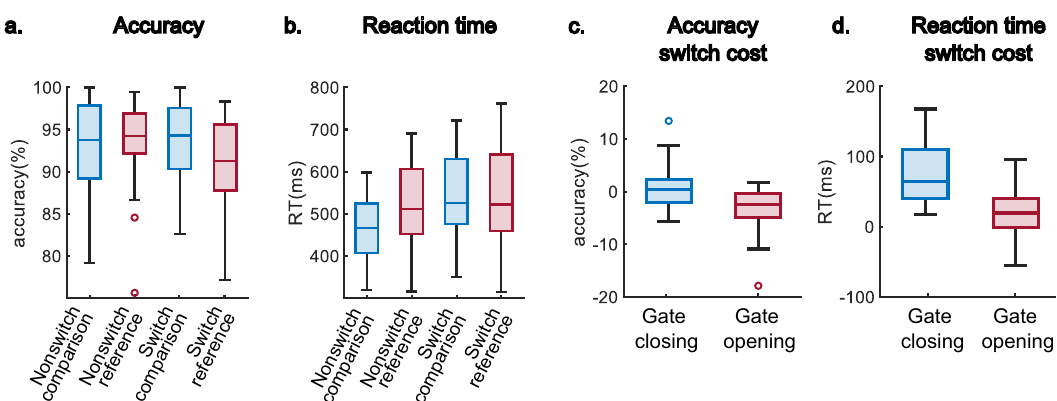
Fig. 1 Behavioral results for gate opening and gate closing. Behavioral results derive from N = 33 participants. Plots a and b reveal the accuracy and reaction time (RT) in each condition, respectively. Plots c and d show the switching costs of accuracy and RT. For each box, the central line indicates the median value, the bottom edge of the box indicates the 25th percentiles, and the top edge indicates the 75th, and each dot represents an outlier identi fi ed by Matlab ’ s ‘ boxchart